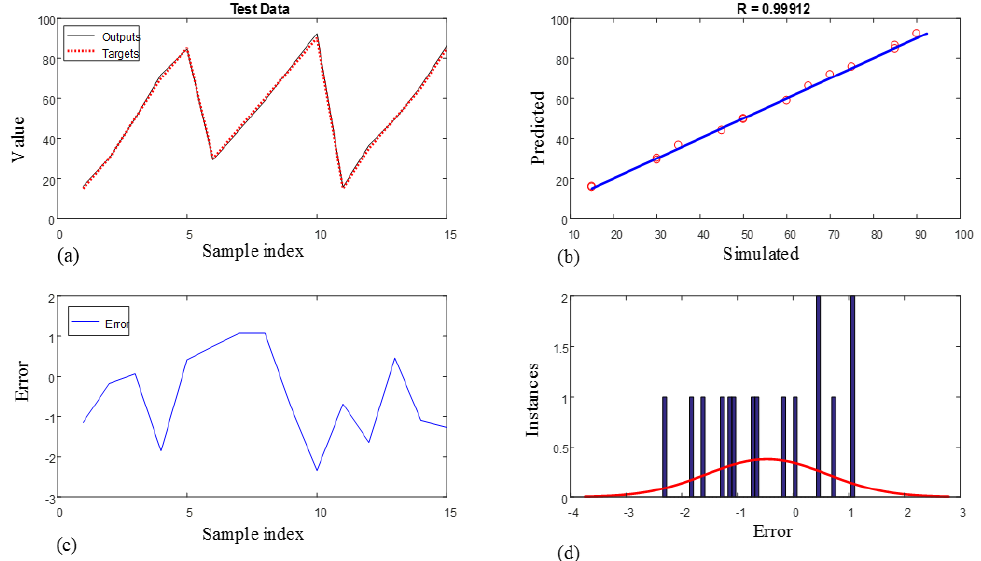
Figure 14. Outcomes of the testing process for void fraction measurement: ( a ) fitting, ( b ) regression, ( c ) error, ( d ) error histogram diagram.